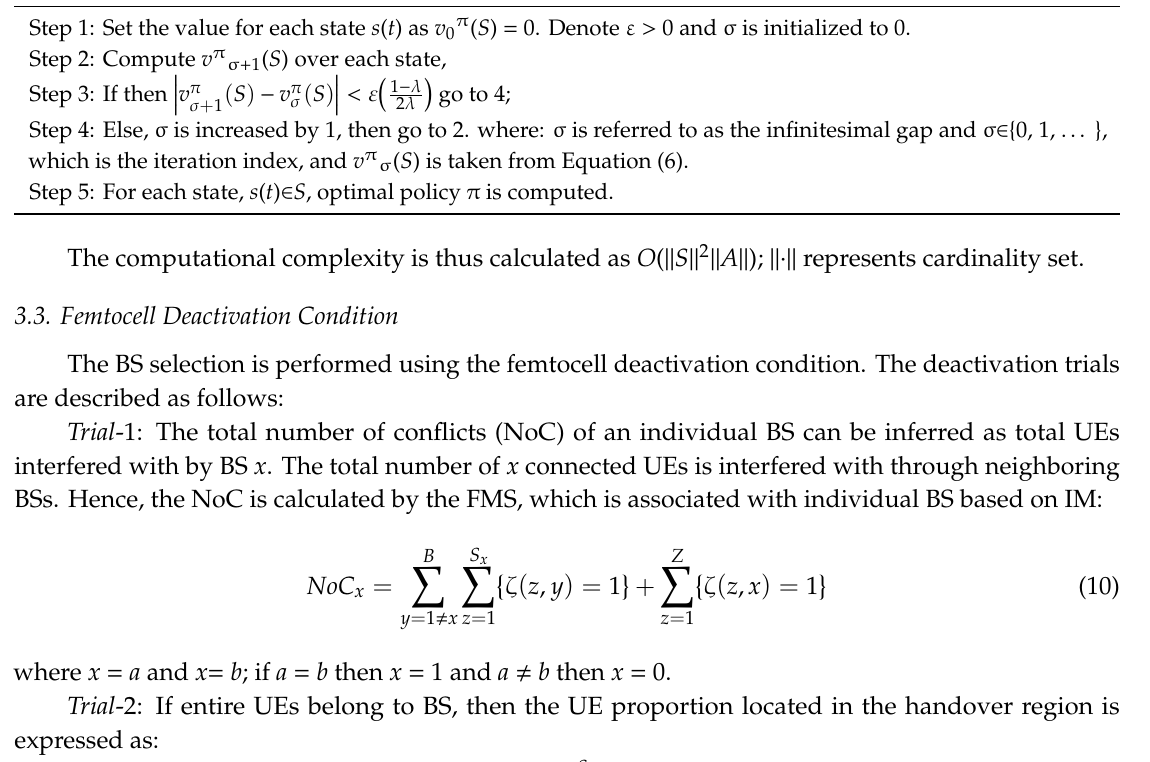
Algorithm 1. Iteration